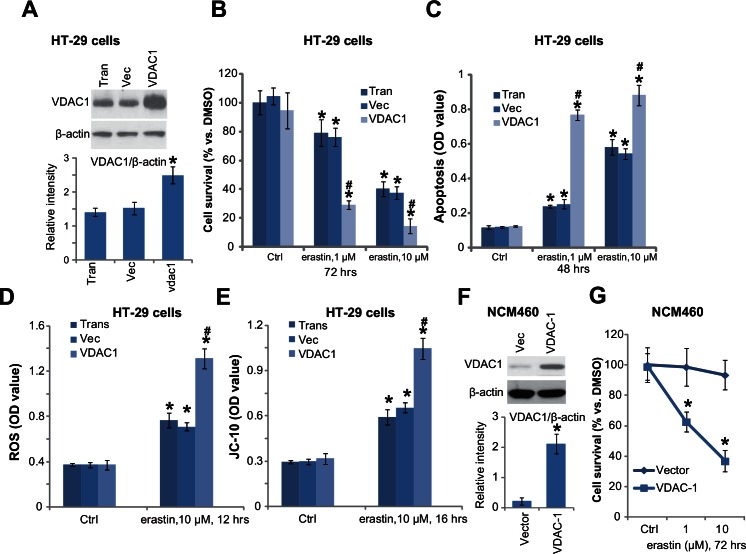
VDAC-1 over-expression potentiates erastin’s cytotoxicity.Stably HT-29 cells or NCM460 colon epithelial cells expressing empty vector (pSuper-puro, “Vec”) or VDAC-1 cDNA (“VDAC-1”) were treated with designed erastin for applied time, VDAC-1 expression, cell survival and apoptosis were tested by Western blotting assay (A and F), MTT assay (B and G) and histone DNA ELISA assay (C), respectively; ROS production (D) and JC-10 intensity (E) were also analyzed. For each assay, n = 4. The data presented were mean ± SD. Experiments were repeated three times with similar results obtained. VDAC-1 expression was quantified (F).* p < 0.05 vs. Ctrl group of “Vec” cells (B-E). # p < 0.05 vs. erastin group of “Vec” cells (B-E). “Trans” stands for transfection control (D and E).